Question: Briefly state, in one sentence, what is plotted here.
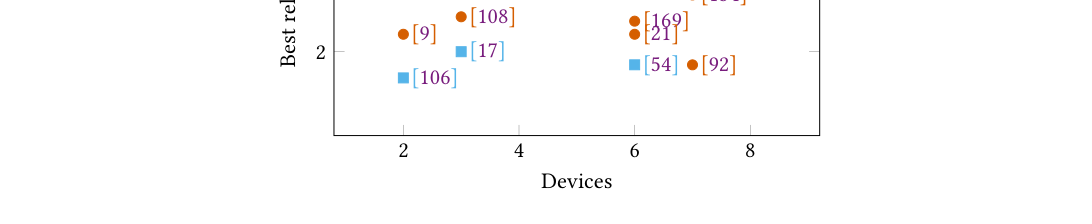
Answer: Best latency speedup (when compared against the case with only one edge device) reported for papers using vertical partitioning